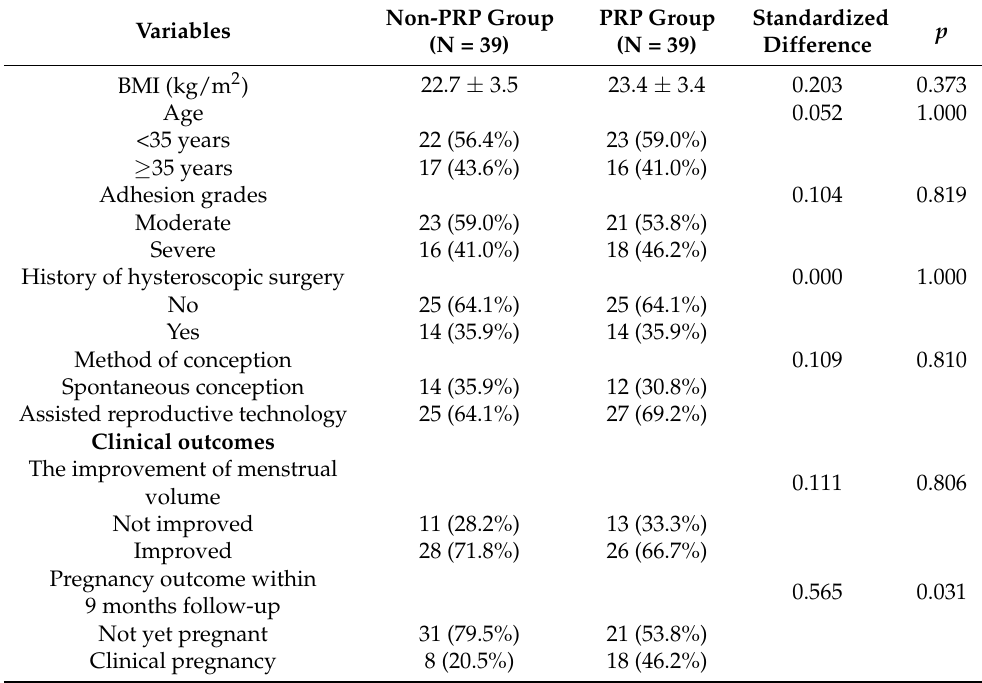
Table 4. Characteristics of propensity-matched groups.